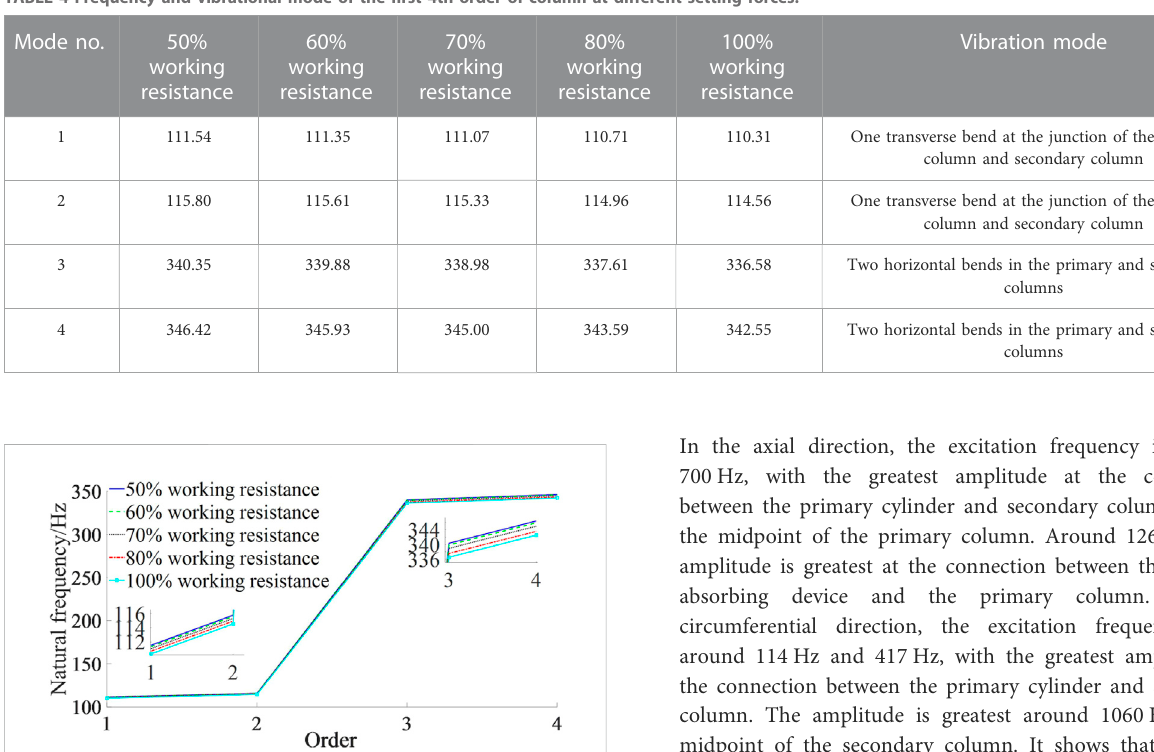
FIGURE 6 Natural frequency – order curves of column for different setting